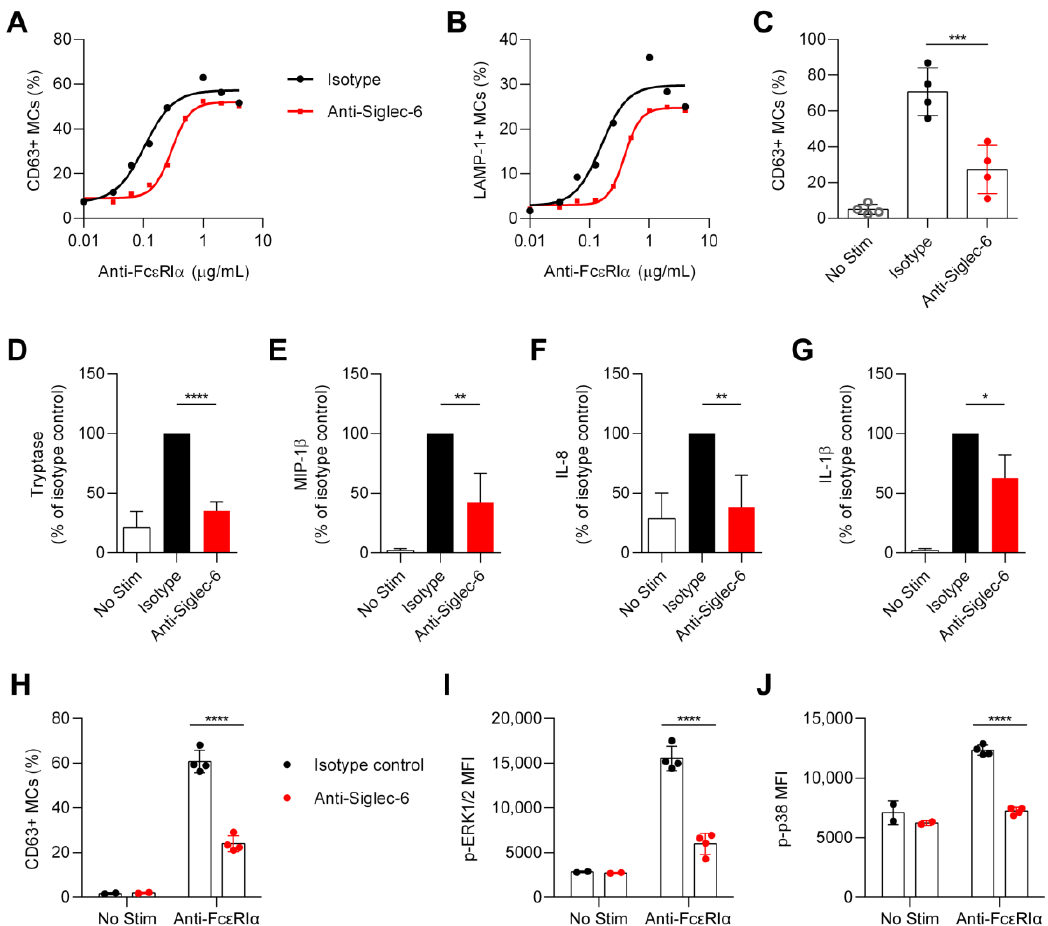
Figure 5. Co-crosslinking of Siglec-6 and Fc ε RI α on MCs enhances inhibitory activity. ( A , B ) CD34+ cell-derived MCs were incubated with the indicated concentration of anti-Fc ε RI α , as well as anti- Siglec-6 or isotype control mAb. Antibodies were crosslinked using secondary anti-mouse IgG antibody, and cells were incubated at 37 ◦ C for 20 min to permit cell stimulation. The percentage of CD63+ ( A ) or LAMP-1+ ( B ) MCs was then determined by flow cytometry. ( C – G ) CD34+ cell-derived MCs were incubated with 150 ng/mL anti-Fc ε RI α and either anti-Siglec-6 or isotype control mAb, or were not incubated with mAbs (No Stim). Expression of CD63 ( C ) was determined by flow cytometry, and tryptase release ( D ) was measured colorimetrically in cell-free supernatant after 20 min of stimulation. MIP-1 β ( E ), IL-8 ( F ), and IL-1 β ( G ) were detected in cell-free supernatant after overnight stimulation. Levels were normalized to those measured in the stimulated samples incubated with the isotype control antibody ( D – G ). ( H – J ) CD34+ cell-derived MCs were incubated in the presence or absence (No Stim) of 150 ng/mL anti-Fc ε RI α with either anti-Siglec-6 or isotype control mAb. Antibodies were crosslinked using secondary anti-mouse IgG antibody, and cells were incubated at 37 ◦ C for 15 min in complete medium to permit cell stimulation. Following stimulation, cells were fixed and stained for surface CD63 ( H ), intracellular phospho-ERK1/2 ( I ), or intracellular phospho-p38 ( J ). Data are representative ( A , B ), represent the means and standard deviations of four ( C – E ) or three ( F , G ) independent mast cell cultures and experiments, or represent the individual values, means, and standard deviations of two ( H – J : No Stim) or four ( H – J : Anti-Fc ε RI α ) replicates. * p < 0.05; ** p < 0.01; *** p < 0.001; **** p < 0.0001 by one-way ANOVA with Tukey test to correct for multiple comparisons ( C – G ). **** p < 0.0001 by two-way ANOVA with Šid á k correction for multiple comparisons ( H – J